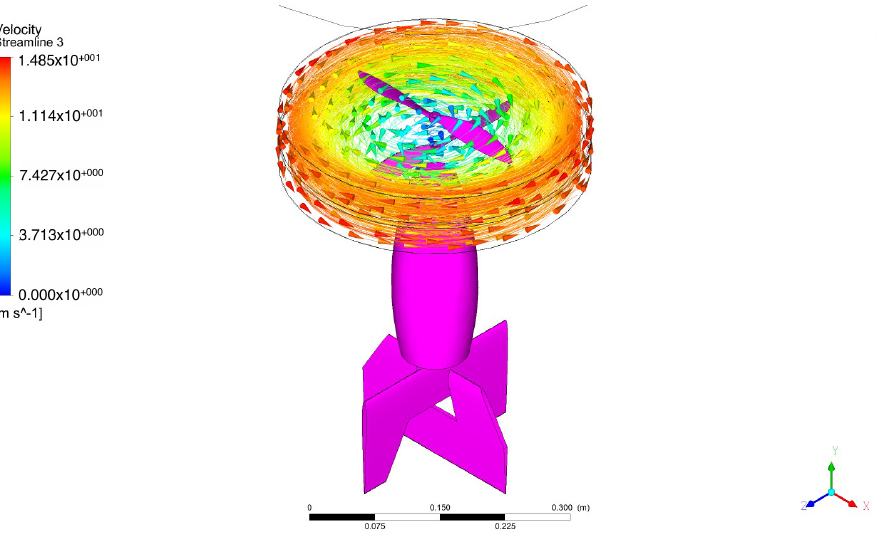
Figure 6. MCR UAV v3.0 velocity